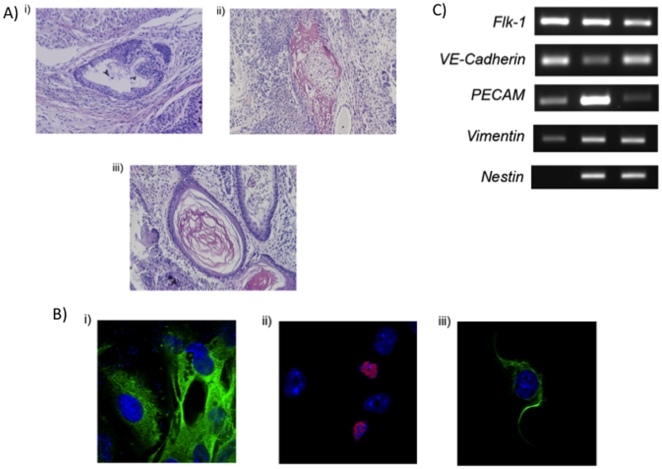
Histology and Hematoxylin and Eosin staining of teratoma tissue from ViO-ES9 cells showing differentiation into tissues indicative of the three germ layers (A) including secretory epithelium (i), articular cartilage (ii) and keratinized epithelium (iii).Immunoflorescent analysis of differentiation into all three germ layers (B): AFP (i); GATA-4 (ii); and NESTIN (iii). Secondary antibodies were labelled with Alexa Fluro® 488 (green) except for GATA-4 which was labelled with Alexa Fluro® 594 (red). Nuclei are stained with DAPI (blue). RT-PCR for Flk-1, VE-Cadherin, PECAM, Vimentin and Nestin (C).